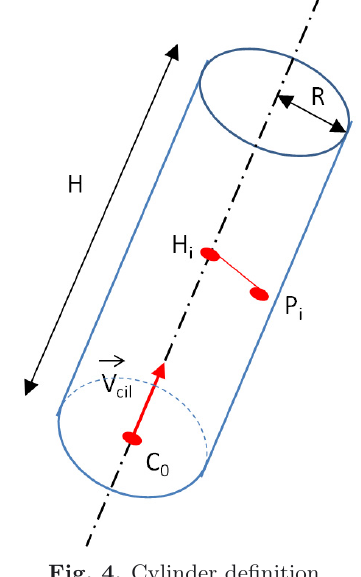
Fig. 4. Cylinder definition.